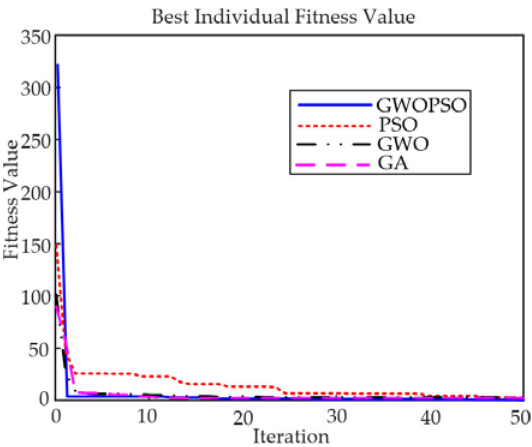
Figure 9. The ITAE iteration curves under no-load condition.